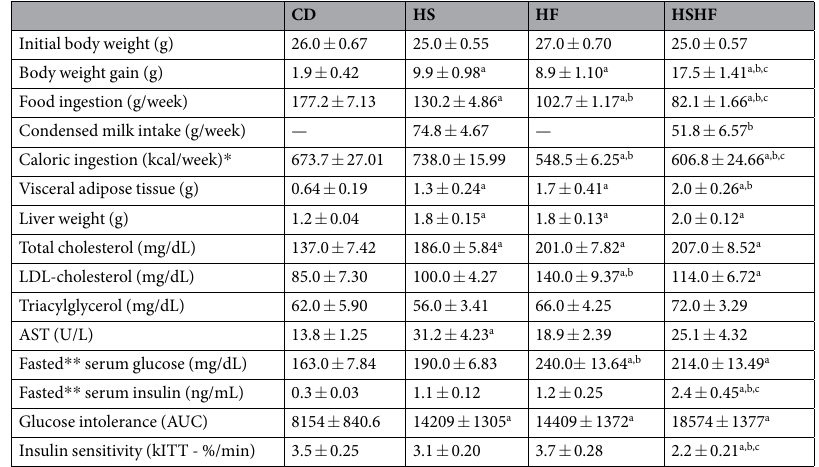
Table 1. Body weight, food intake and serum metabolites levels in mice fed either the control diet or obesogenic diets (high-sugar (HS), high-fat (HF) and high-sugar/high-fat (HSHF)) for eight weeks. * Caloric ingestion considered the food ingestion calories for CD and HF group and food ingestion plus condensed milk intake calories for HS and HSHF groups; ** Fasted for 3–4 hours. CD, control diet; HS, high-sugar diet; HF, high-fat diet; HSHF, high-sugar/high-fat diet; LDL-cholesterol, low density lipoprotein cholesterol; AST, aspartate aminotransferase; AUC, area under the curve of glycaemia - values obtained from the glucose tolerance test (GTT); kITT (%/min), the constant rate for plasma glucose disappearance - values obtained from the insulin tolerance test (ITT). The results are shown as the mean ± S.E.M. (n = 12–13). The values were analysed using the one-way ANOVA and Tukey’s post-test. (a) P < 0.05 versus CD; (b) P < 0.05 versus HS; and (c) P < 0.05 versus